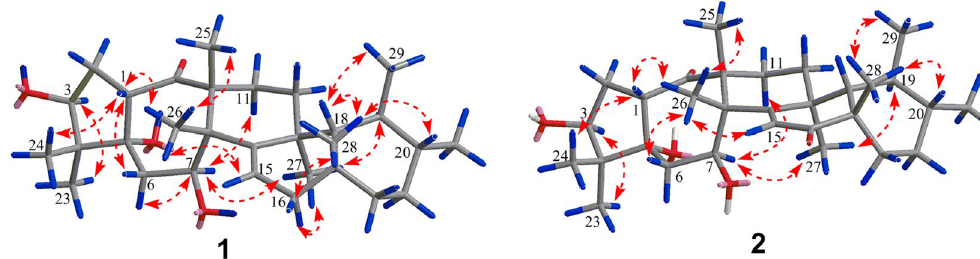
Figure 3. Key NOE correlations for ( 1 ) and ( 2 ).